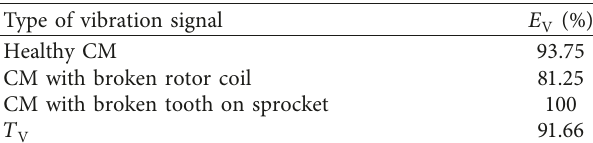
Table 4: The results of recognition of vibration signals—the MSAF- Figure 10: Steps of the LDA. RATIO-50-SFC-EXPANDED and the NM classifier were used.